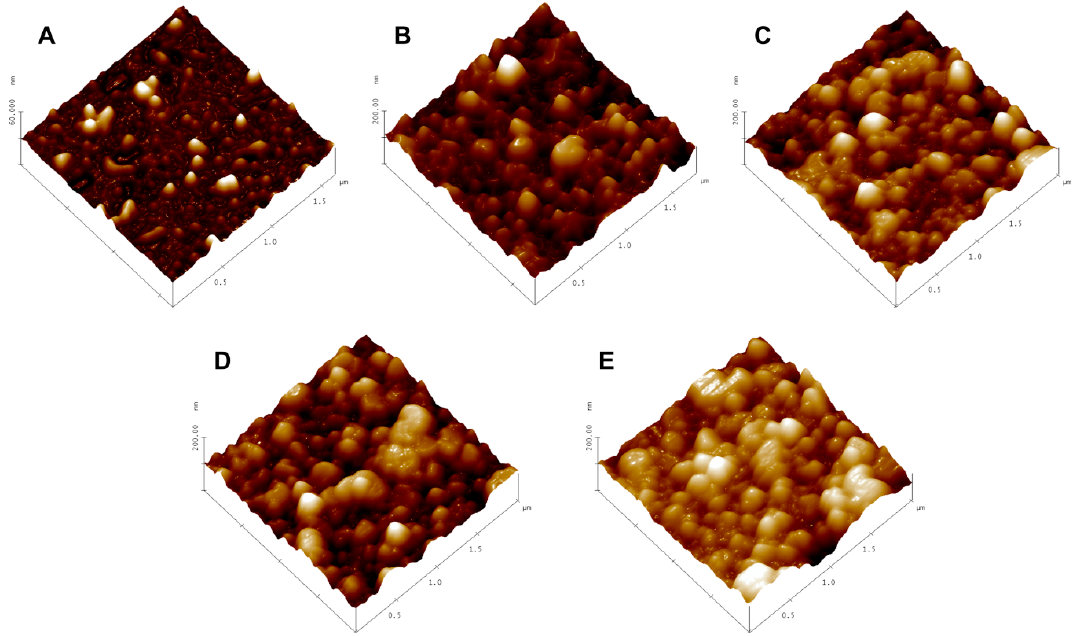
Figure 1. ( A ) AFM micrograph of linear polyethylenimine (PEI) polyplexes; ( B – E ) AFM micrographs of HV1, gHV1, HV2, and gHV2 hybrid vectors, respectively. Images were obtained in the intermittent contact mode at a resonance frequency of 170 kHz and a force constant of 40 N/m. Scale bars across all the micrographs represent 2 µm.